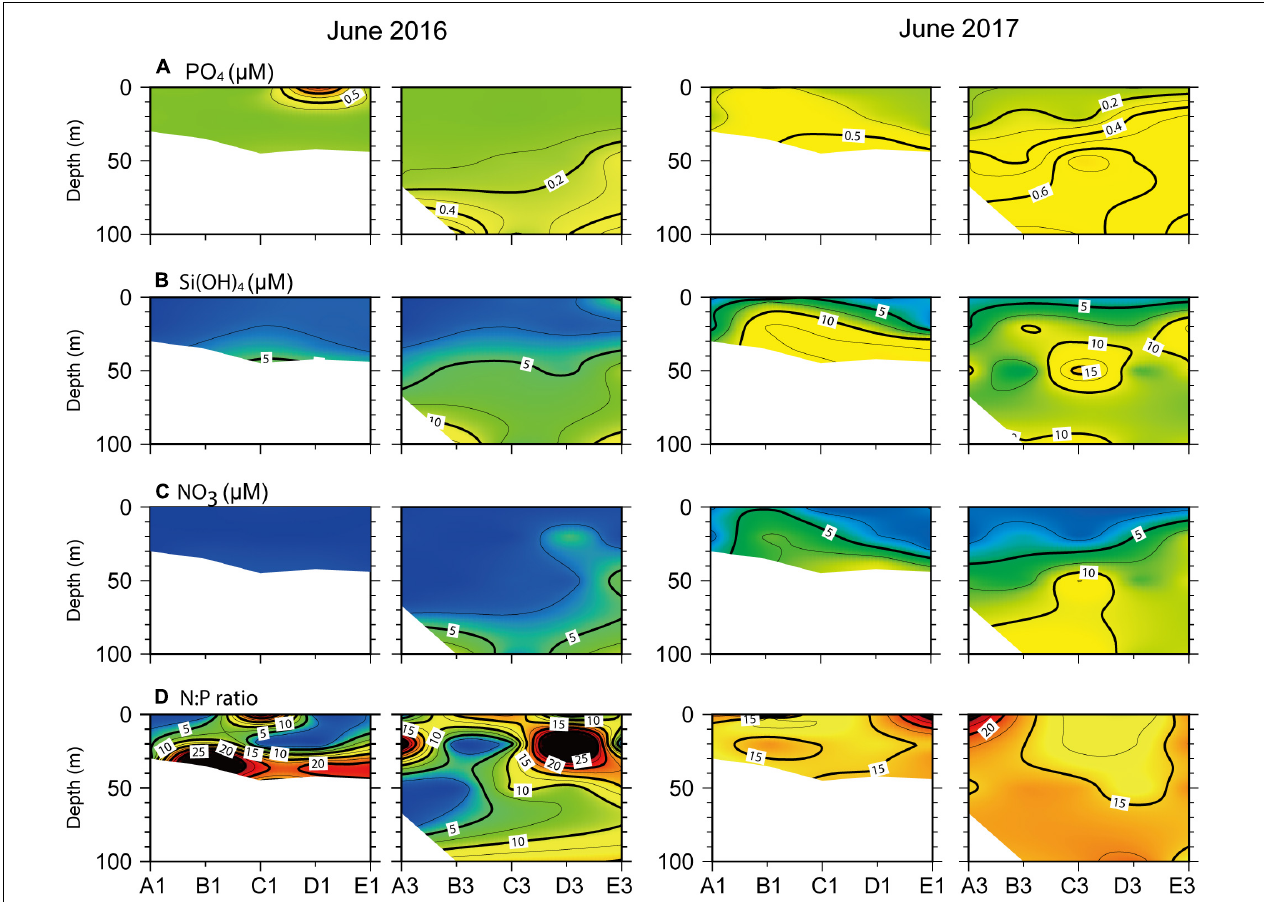
FIGURE 7 | Vertical profiles of dissolved inorganic nutrient concentrations, (A) PO 43 − , (B) Si(OH) 4 , (C) , NO 3 − , and (D) N:P ratio, across the north–south longitudinal transects of nearshore (left) and offshore (right) stations (see Figure 1 ) in June 2016 and